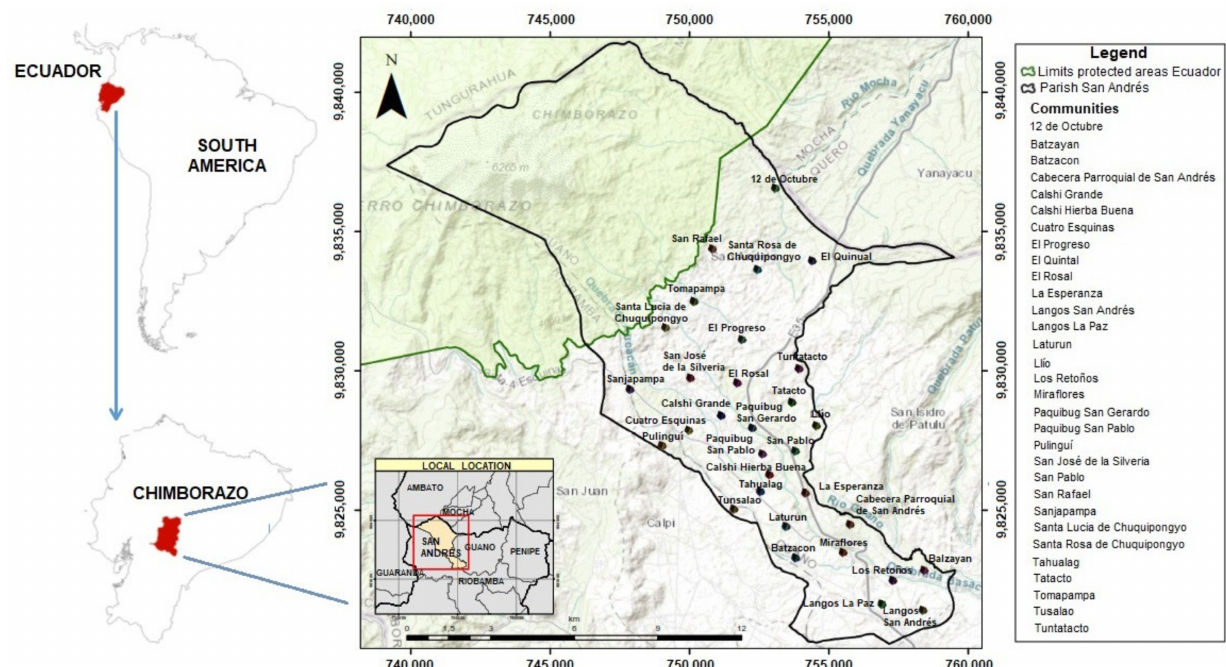
Figure 1. Geographical locations of the studied communities.